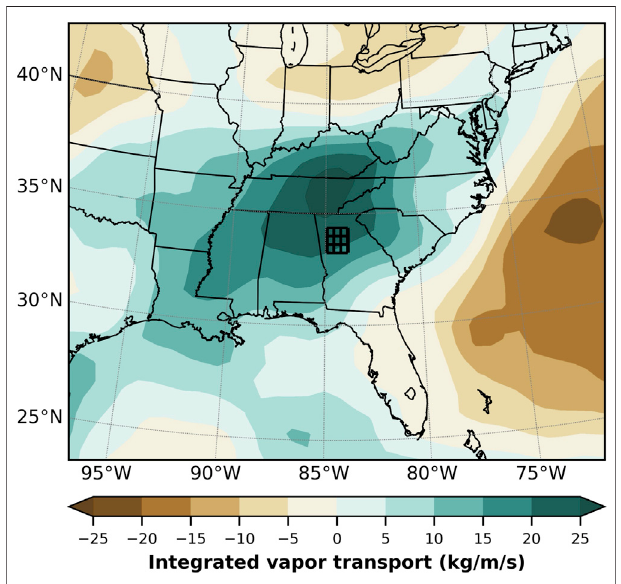
FIGURE 8 | Composite anomaly map of integrated vapor transport for URDs compared to non-URDs. The 9-cell gridded framework centered on Atlanta is indicated by the black-outlined boxes.